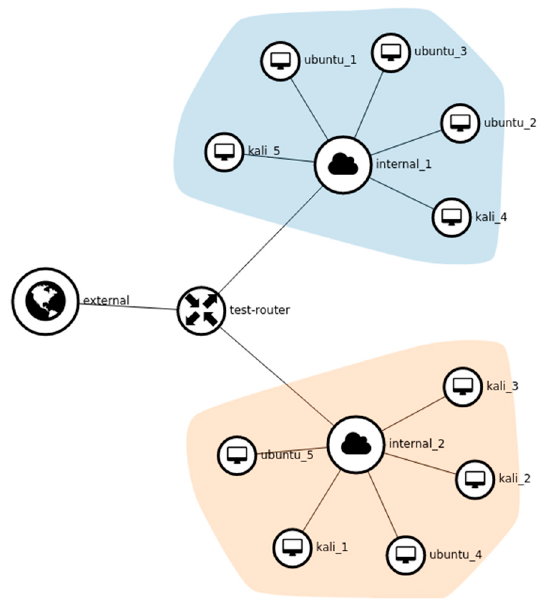
Figure 1. OpenStack network environment.